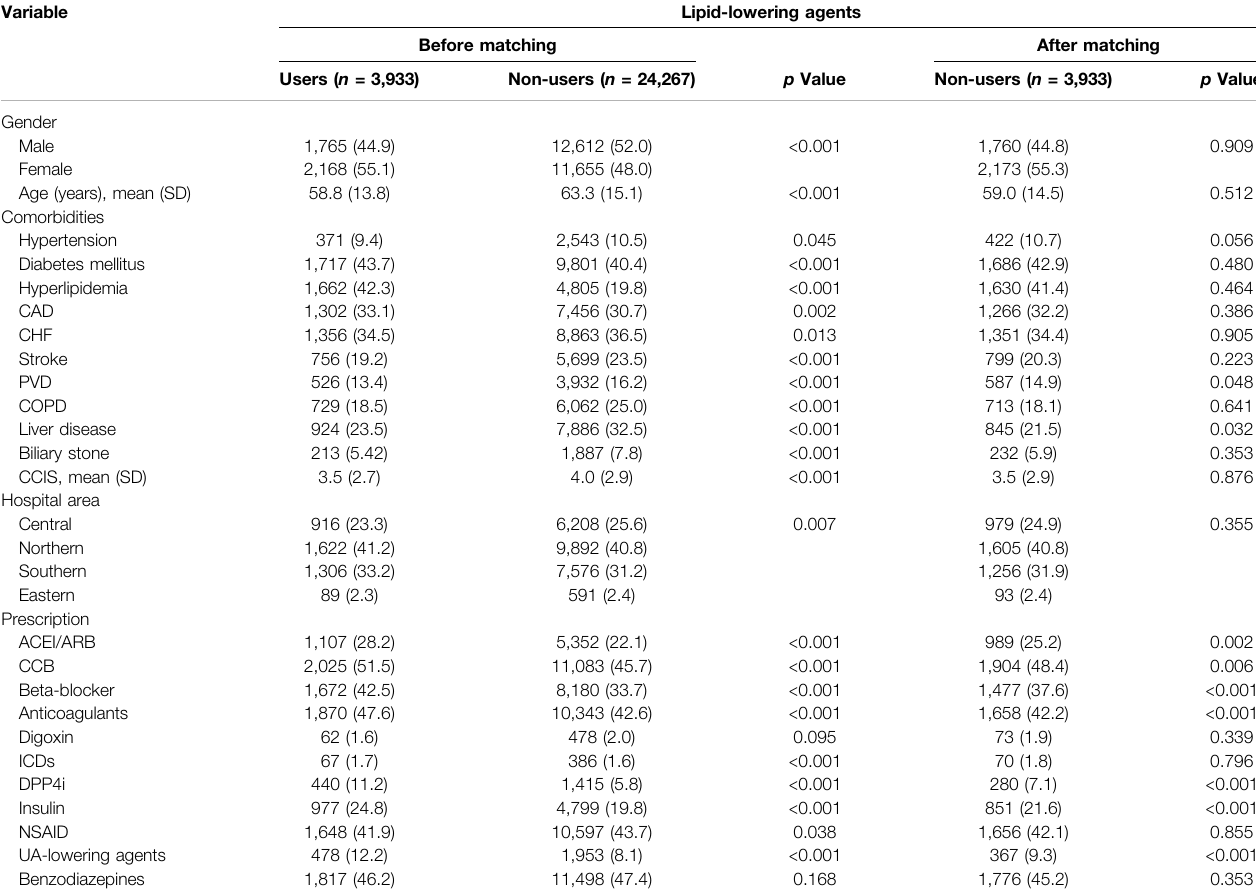
TABLE 1 | Demographic and clinical characteristics of dialysis patients.